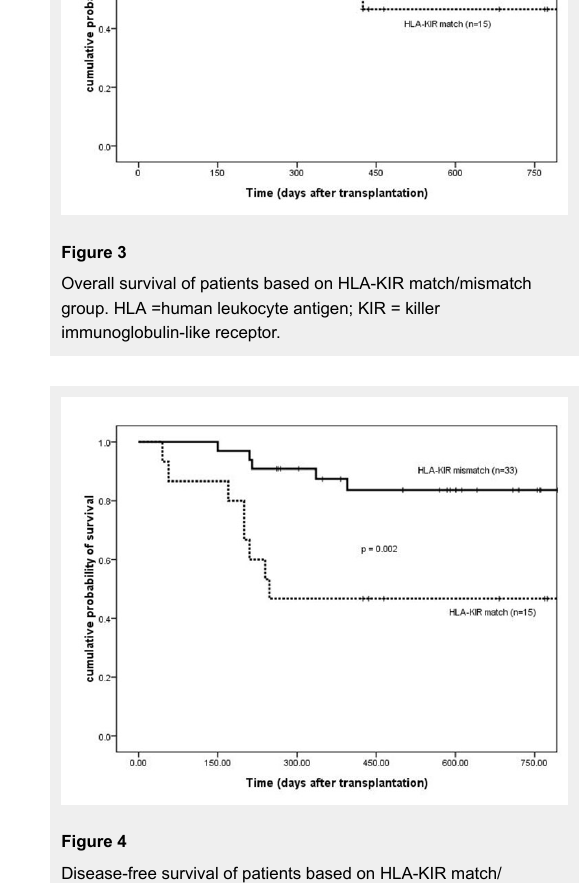
Disease-free survival of patients based on HLA-KIR match/ mismatch group. HLA = human leukocyte antigen; KIR = killer immunoglobulin-like